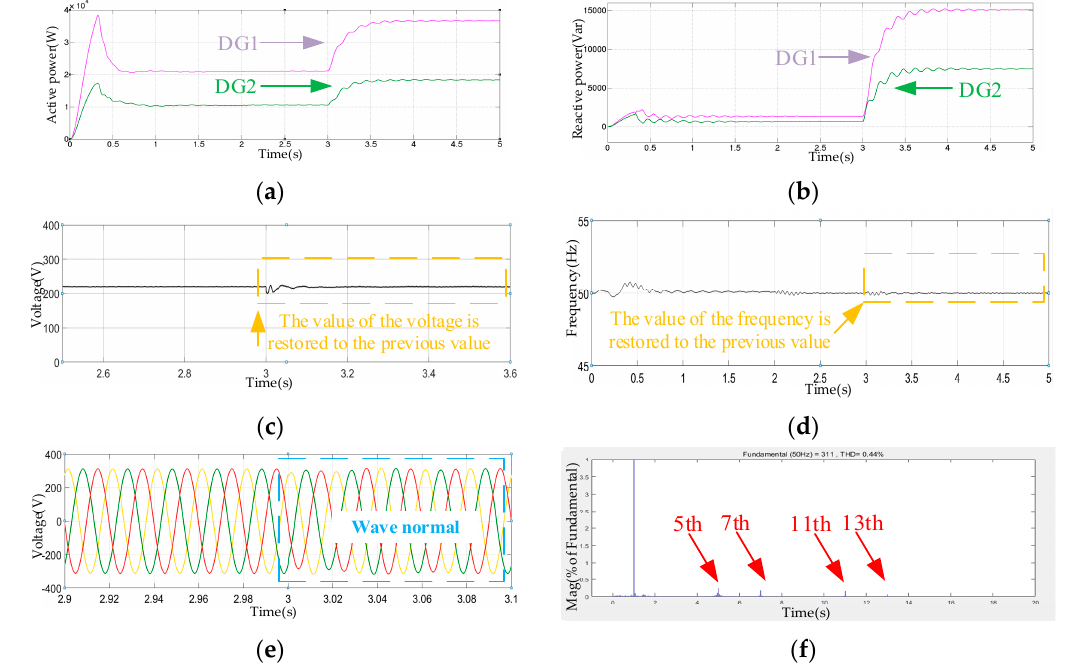
Figure 13. ( a ) Active power of DG1 and DG2 Inverters; ( b ) Reactive power of DG1 and DG2 Inverters; ( c ) The voltage value of PCC; ( d ) The frequency value of PCC; ( e ) Voltage waveform of PCC; ( f ) Voltage FFT analysis of PCC.